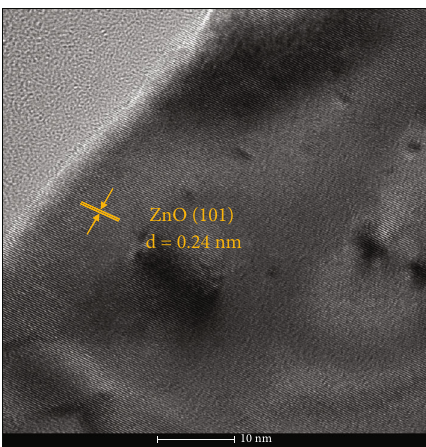
Figure 4: HRTEM image of the 3 at% Ag-functionalized porous ZnO